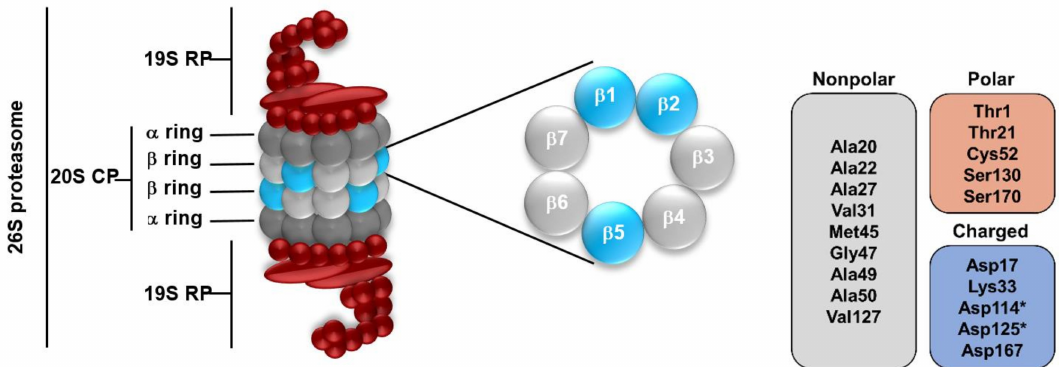
Figure 2. (Left) The eukaryotic 26S proteasome and the three catalytic subunits of the β ring: β 1, β 2 and β 5. (Right) Residues that line the chymotrypsin-like (CT-L) catalytic site, on which we focus in this paper’s analyses. Residues with * belong to the β 6 subunit, otherwise they belong to the β 5